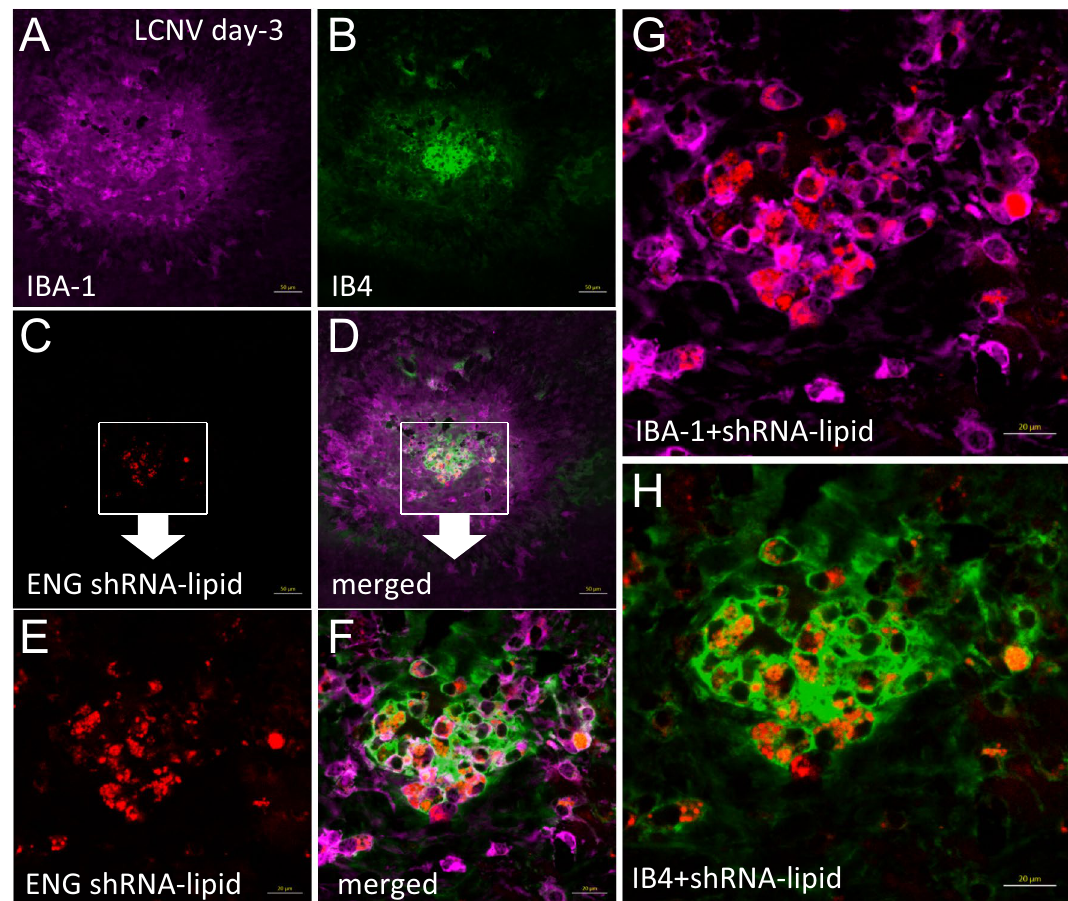
Figure 8. Co-localization of AS-Eng shRNA–lipid fluorescence with IBA1 positive cells in a mouse model of laser-induced choroidal neovascularization (LCNV). The LCNV mice received intraperitonel injections of AS-Eng shRNA–lipid conjugates on day-3 post-laser injury. Eighteen hours post-injection, RPE-choroid complex tissues were analyzed ex vivo. ( A , B ) IBA1 was used to visualize the microglia/macrophages and IB4 was used to visualize the neovascular lesions. ( C , D ) Showing AS-Eng shRNA–lipids are associated with IBA1 + microglia/macrophages in choroidal neovascularization . ( E , F ) magnification of ( C ) and ( D ) images respectively. AS-Eng shRNA–lipid fluorescence is localized in IBA1 positive cells, suggesting that endolgin positive microglia/macrophages are associated with choroidal neovascularization. ( G , H ) Larger view of the LCNV lesion showing co-localization of AS-Eng shRNA–lipids with IBA1 positive macrophages, as shown in ( G ). Interestingly, some of the AS-Eng shRNA–lipids positive IBA1 stained cells are also stained positive for IB4, as shown in ( H